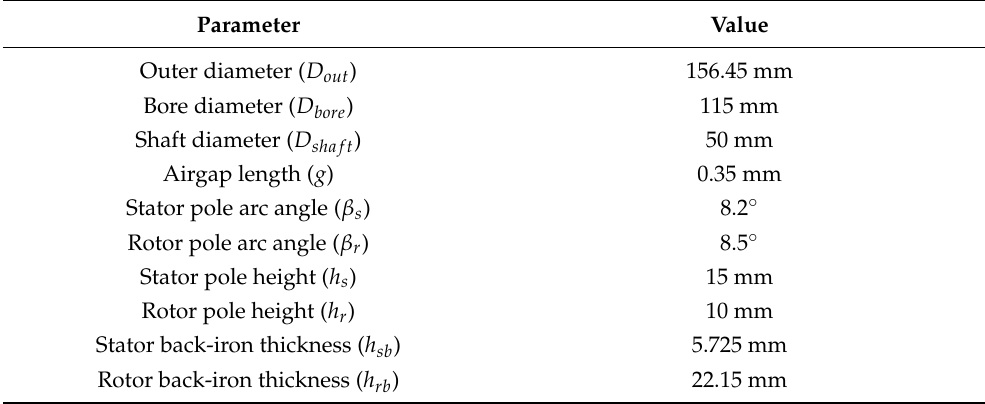
Table 4. Proposed dimensions of the SRM